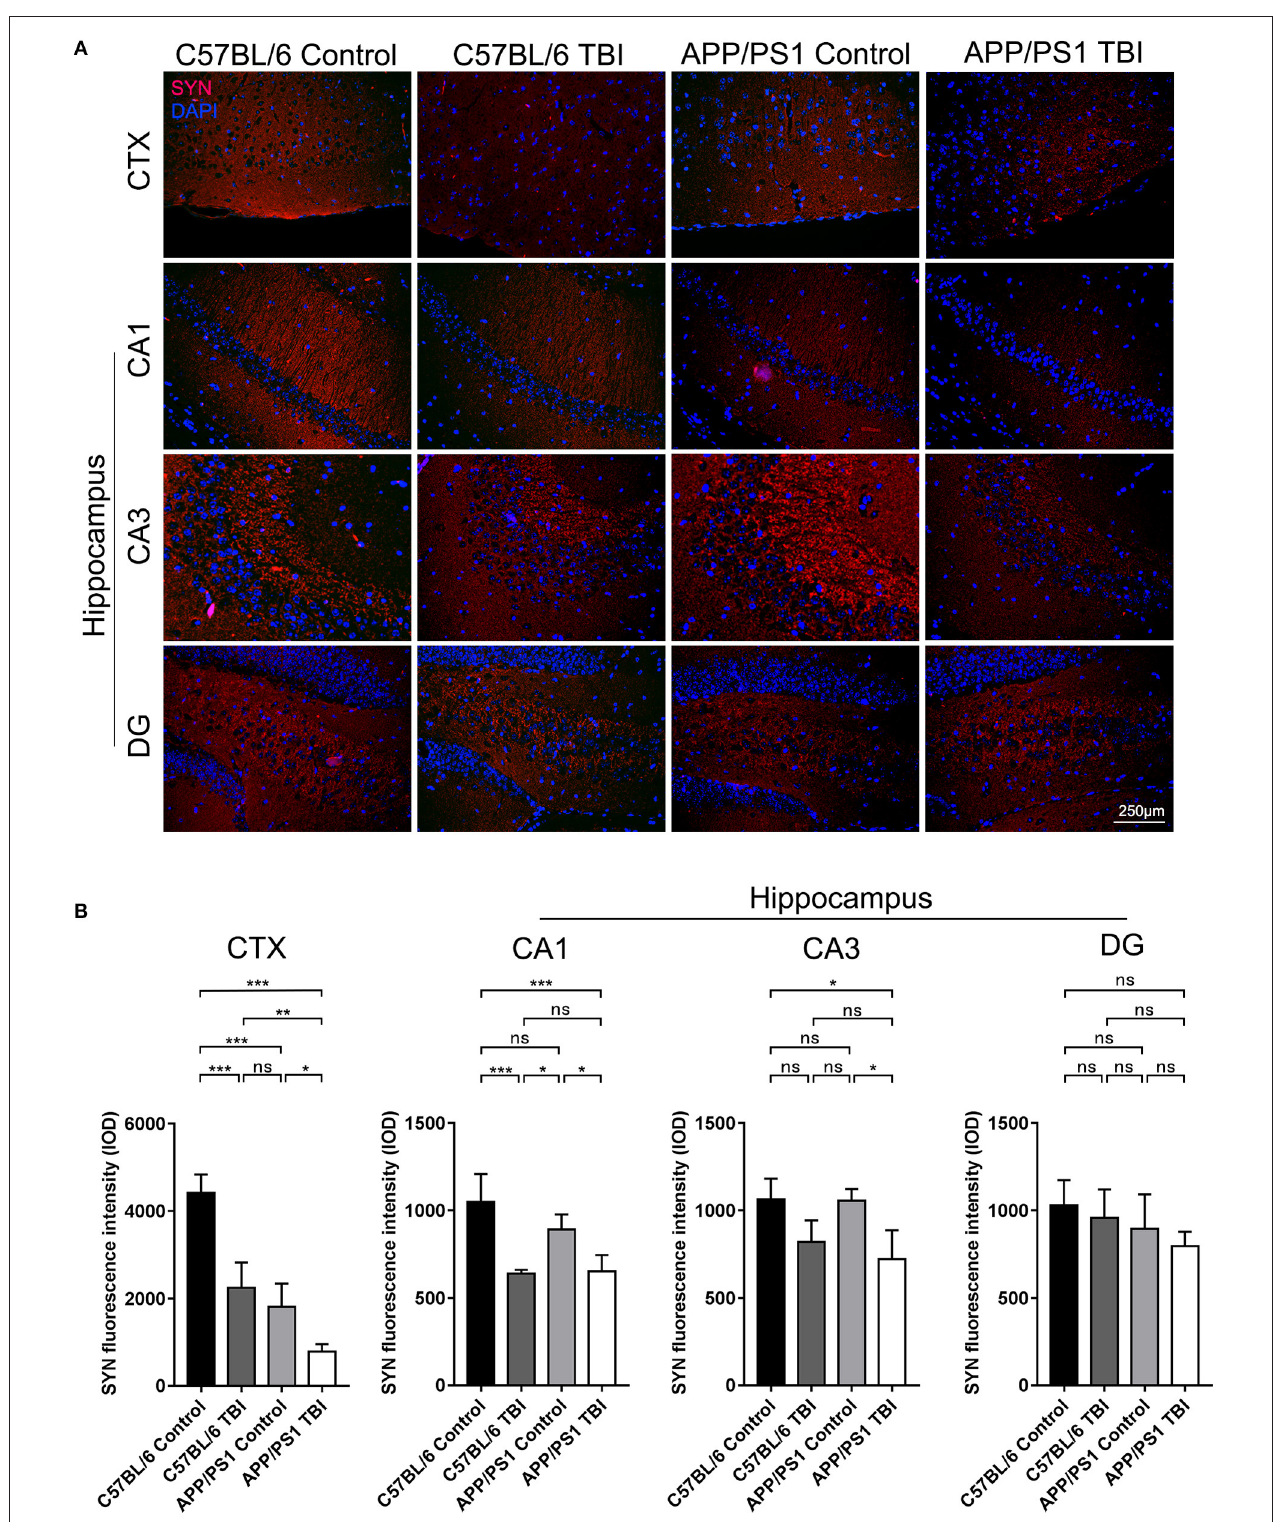
FIGURE 3 | Synapse formation in the cortex and hippocampus deteriorated in APP/PS1 mice after TBI. (A) Representative fluorescence images of cortical and hippocampal (CA1, CA3, and DG) tissues from in C57BL/6, C57BL/6 TBI, APP/PS1, and APP/PS1 TBI group mice immunostained for SYN (in red) and subjected to nuclear staining with DAPI (in blue). (B) The fluorescence intensity of SYN in the cortex and in the hippocampus (CA1, CA3, and DG). The error bars represent the SEM ( n = 8/group). ns, non-significant; * p < 0.05; ** p < 0.01; *** p < 0.001.